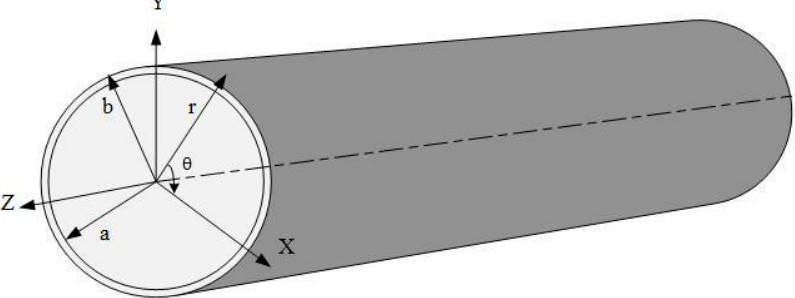
Figure 3. System of cylindrical coordinates (r, θ,z) for a cylindrical waveguide.